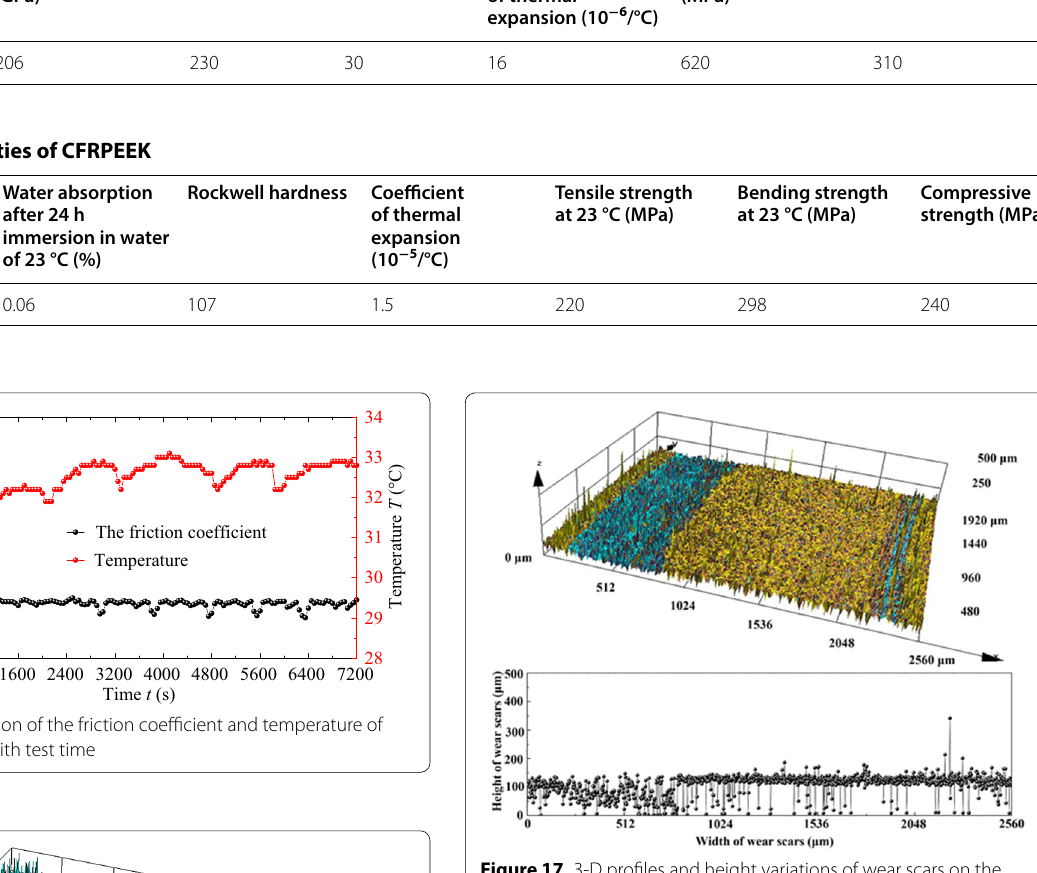
Table 2 Main performance parameters of 316L Density (g/cm 3 ) Modulus of elasticity (GPa)